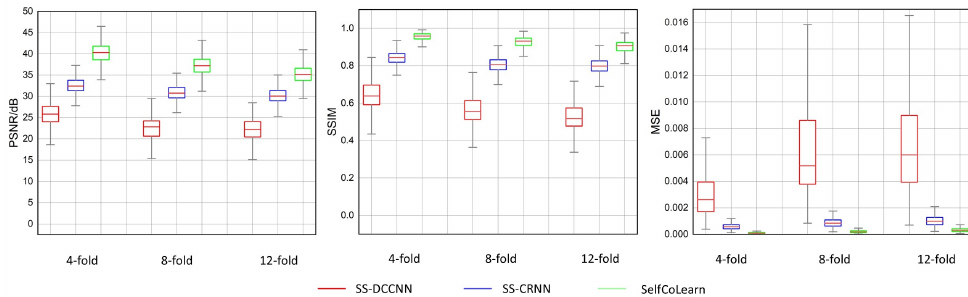
Figure 3. Box plots of different methods (SS-DCCNN, SS-CRNN, and SelfCoLearn) at 4-fold, 8-fold, and 12-fold accelerations are presented, which show the median and interquartile range of the PSNR, SSIM, and MSE on the cardiac cine test dataset.